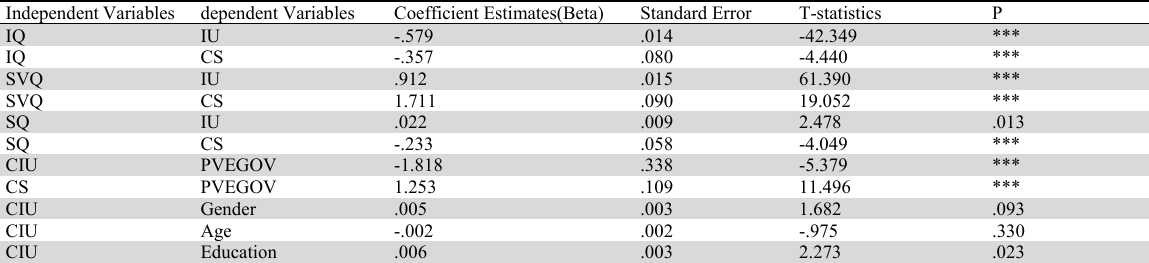
Maximum Likelihood